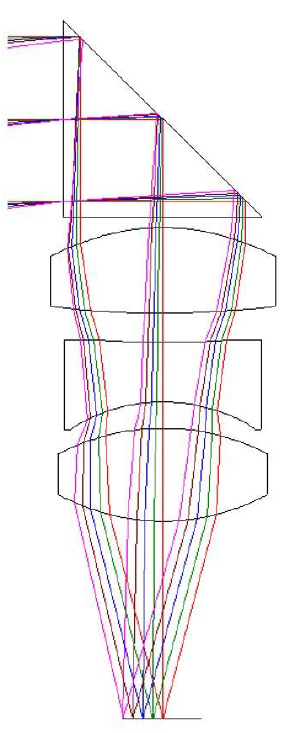
Figure 3. Right angle prism inverted fixed focal lens simulation design.